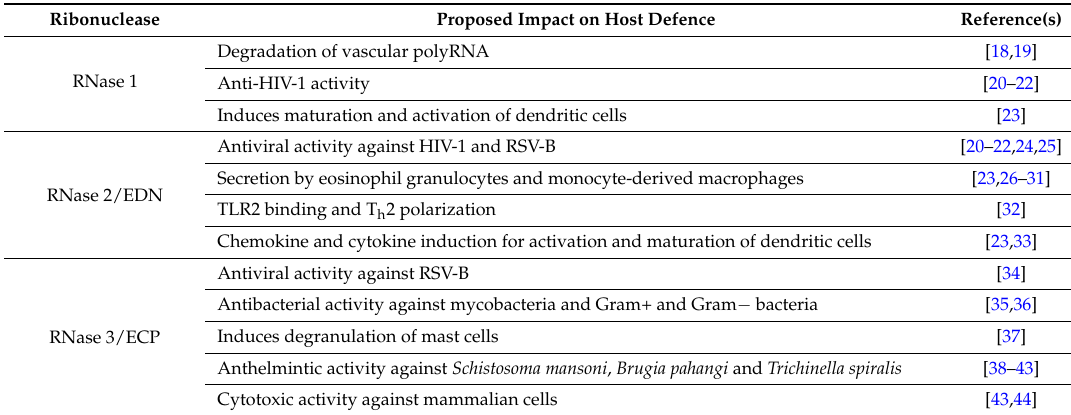
Table 1. Proposed functions of the canonical ribonucleases (RNases) in human host